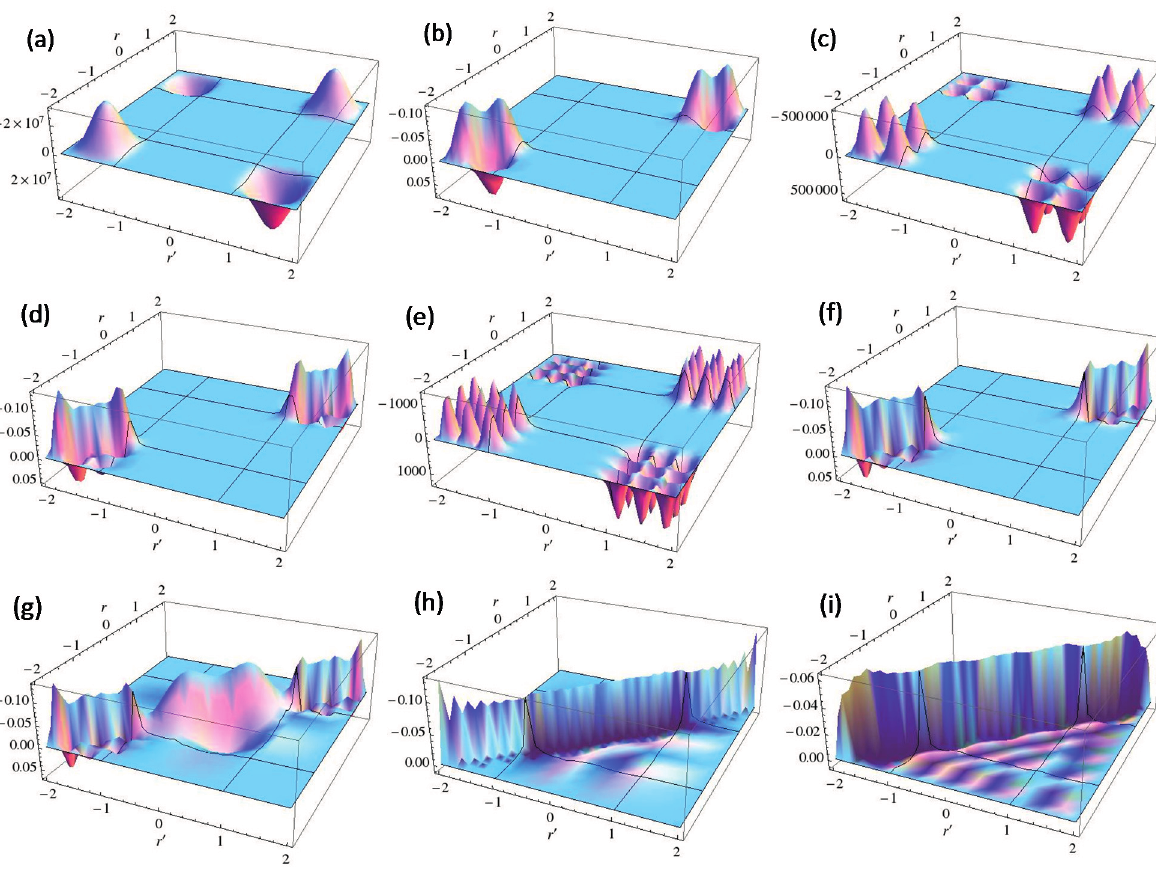
Figure 6. Plots of linear response functions of the double-well potential system (V 0 = 100) for various numbers of occupied orbitals (Nocc). ( a ) Nocc = 1; ( b ) Nocc = 2; ( c ) Nocc = 3; ( d ) Nocc = 4; ( e ) Nocc = 5; ( f ) Nocc = 6; ( g ) Nocc = 7; ( h ) Nocc = 25; ( i ) Nocc =